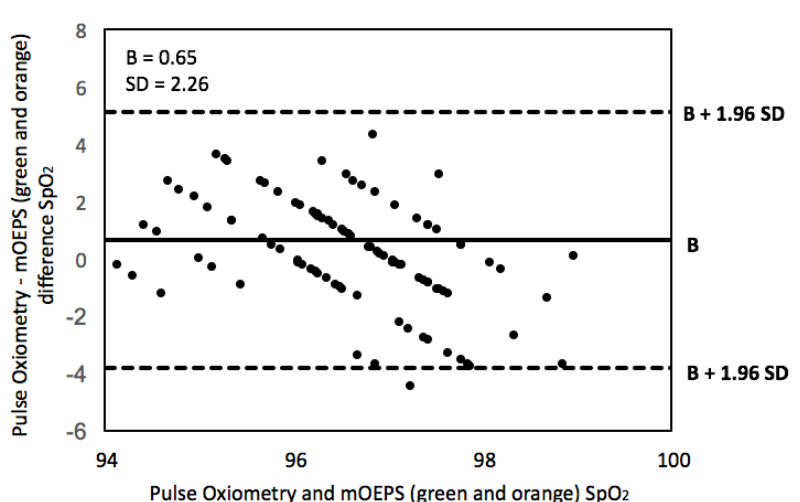
Figure 7. Bland–Altman plot showing differences in SpO 2 between the green and orange illuminations of mOEPS and the pulse oximetry device. The graphs display a scatter diagram of the differences against the averages of the pulse oximetry and the green and orange illuminations of mOEPS for all 15